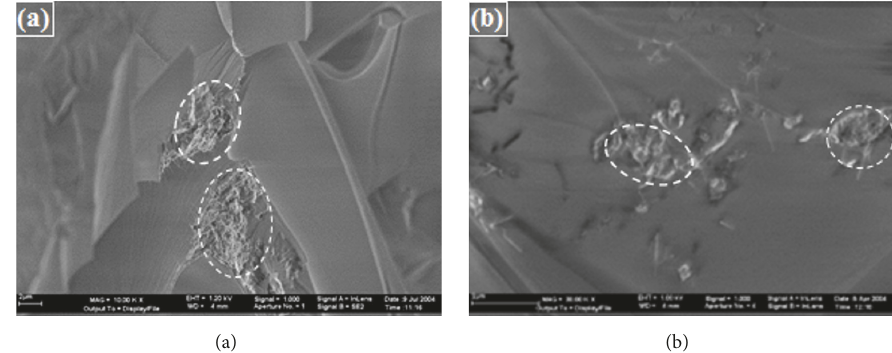
Figure 2: Agglomerates of CNTs observed in GFRP laminates